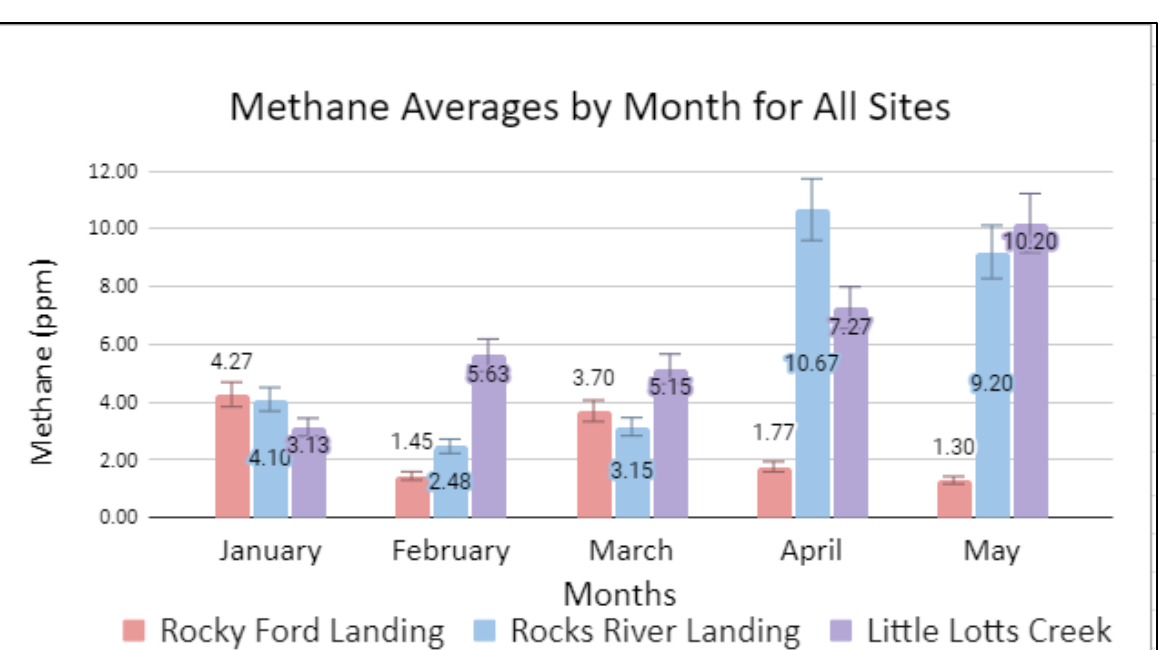
Figure 3. Air Quality — Ammonia (NH 3 ) Gas Sample Measurements.